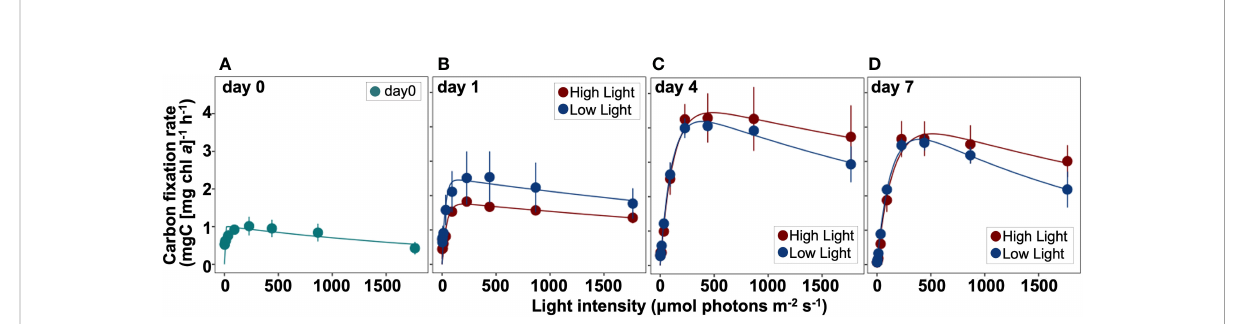
FIGURE 7 Photosynthesis-Energy (P-E) curves during incubation on day 0 (A) , day 1 (B) , day 4 (C) , and day 7 (D) fi tted by the photoinhibition model of Platt et al. (1980). The vertical axis indicates the carbon fi xation rate normalized by chl a concentration (mg C [chl a ] -1 h -1 ), and the horizontal one indicates the light intensity ( m mol photons m -2 s -1 ) during incubation. The red and blue colors represent the high (300 µmol photons m -2 s -1 ) and low (30 µmol photons m -2 s -1 ) light conditions, respectively. Mean values ( ± SD) indicate the average of three independent measurements.